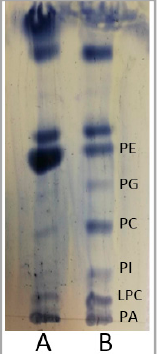
Figure 2. Thin layer chromatography of waste corn gums (lane A) and BF2-S fraction (lane B) with the identification of the main PLs (eluent CHCl 3 / CH 3 OH / NH 3 : 65 / 30 / 2.5).